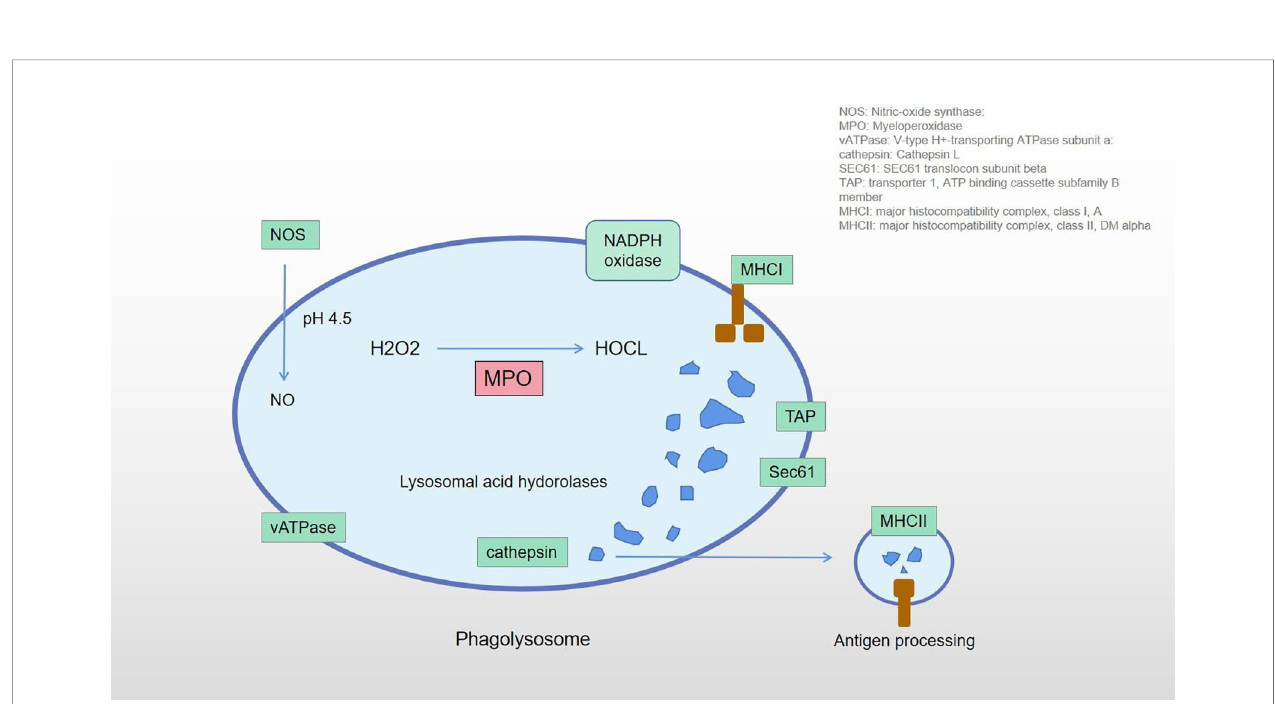
FIGURE 9 | The role of MPO in phagolysosome. Overexpression of the MPO is shown in